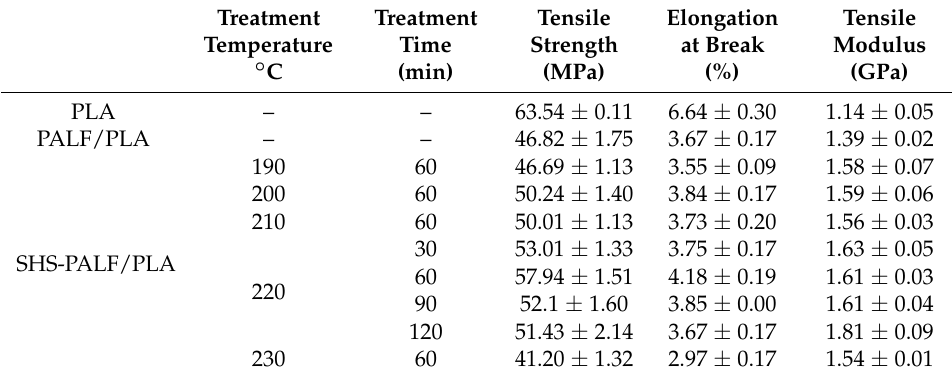
Table 2. Mechanical properties of PALF/PLA and SHS-PALF/PLA biocomposites.